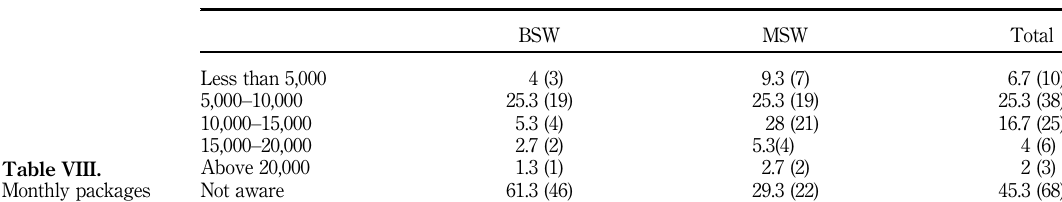
Table VII. Major source of